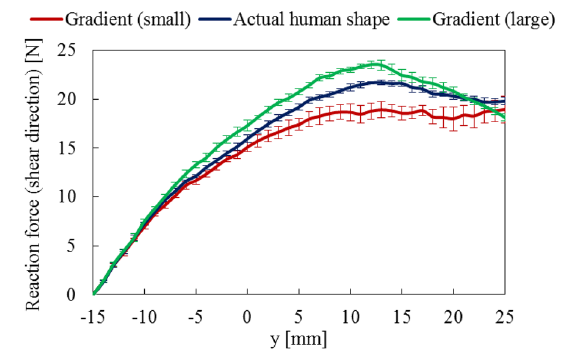
Fig. 14 Interaction force pattern in the shear direction